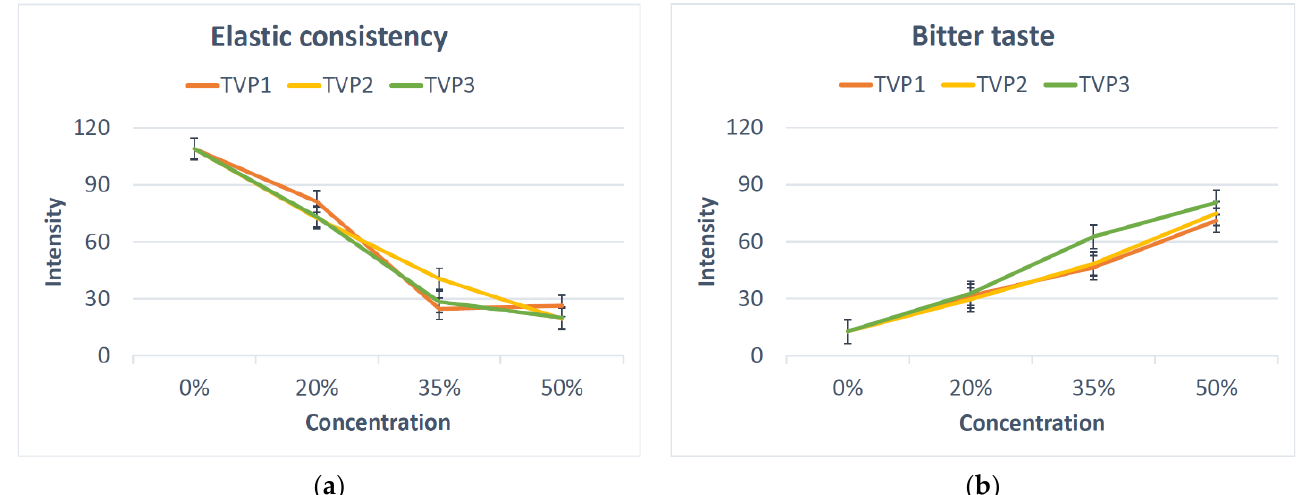
Figure 2. The intensity of the relevant sensory properties ( a ) elastic consistency and ( b ) bitter taste in relation to added type and concentration of plant protein. The results for the reference (REF) are indicated at 0%. TVP1: extrudate with 10% faba bean, 89% pea, 1% salt; TVP2: extrudate with 49% faba bean, 40% pea, 10% quinoa, 1% salt; TVP3: extrudate with 10% faba bean, 79% pea, 10% hemp, 1% salt. The standard error (SE) for the two repetitions is shown in the figure. Table 4. The samples’ average liking rating on a modified 9-point hedonic scale and standard error (SE). A paired t -test was used to test for significant effects of providing information. Liking Likelihood of No Info on Content